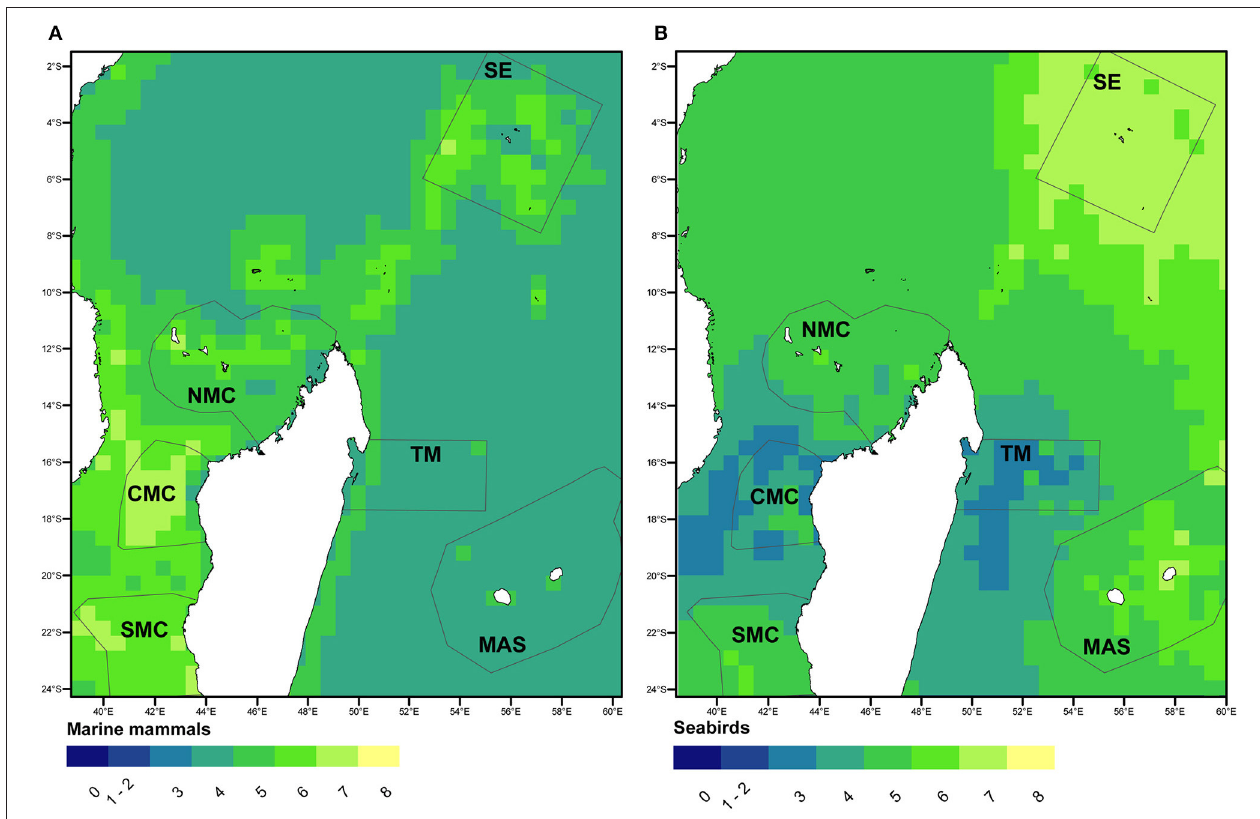
FIGURE 2 | Predicted taxonomic richness from occupancy analyse of marine mammals (A) and seabirds (B) within and outside the survey blocks of the SW Indian Ocean.